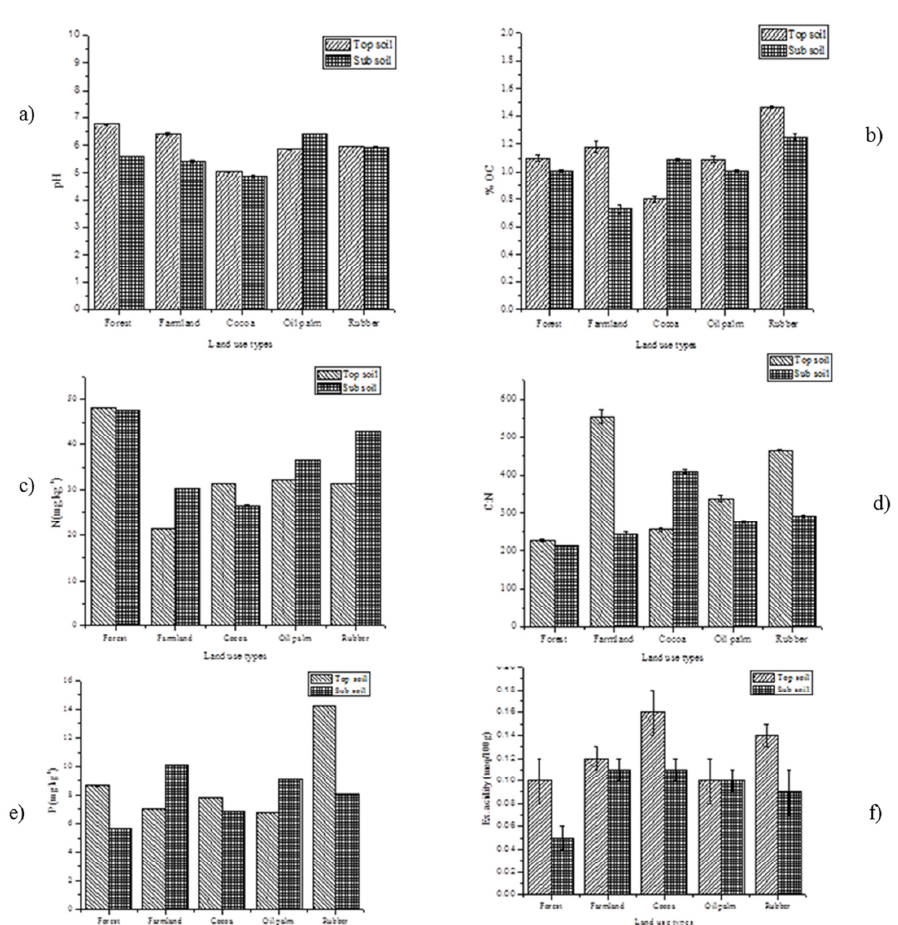
Fig. 1. (a) pH (b) organic carbon (c) N (d) C:N (e) P and (f) exchangeable acidity, in top and sub soil from five different land